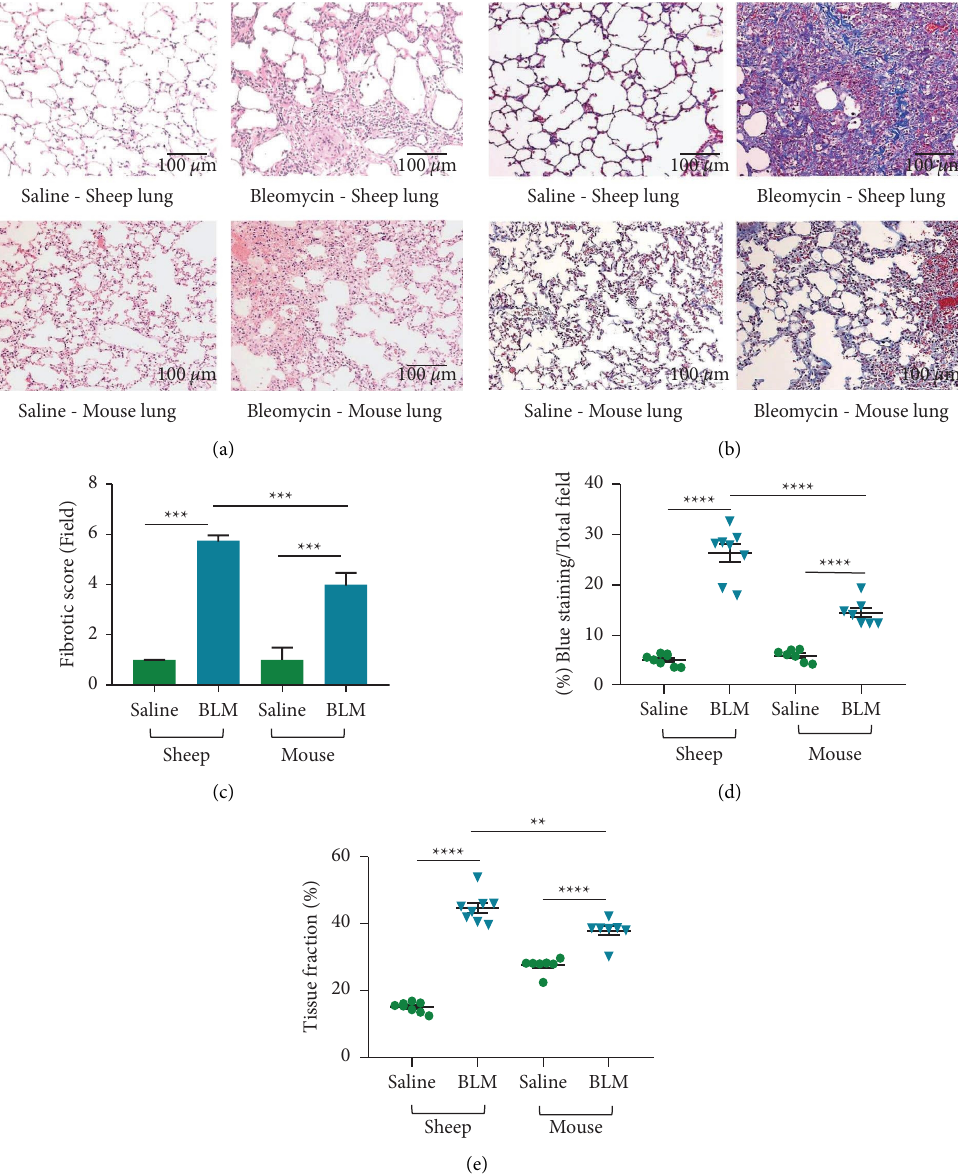
Figure 2: Fibrotic scores, fbrotic fractions, and tissue fractions of sheep ( n � 8) and mouse ( n � 14) lung tissues administered with either saline (control) or bleomycin (treatment). (a) H&E staining was used to evaluate the fbrotic score and tissue fraction. (b) Masson’s trichrome staining was used to evaluate the % of blue staining. Ten representative randomly selected areas from each lung tissue sections were captured under × 20 magnifcation for the analysis. Fibrotic scores (c) were expressed as a median and interquartile range while fbrotic fraction (d) and tissue fraction (e) were expressed as means and standard errors of means. Signifcance was determined using the Mann–Whitney test and one-way ANOVA denoted as follows: ∗∗ p < 0 . 005, ∗∗∗ p < 0 . 0005, and ∗∗∗∗ p < 0 .